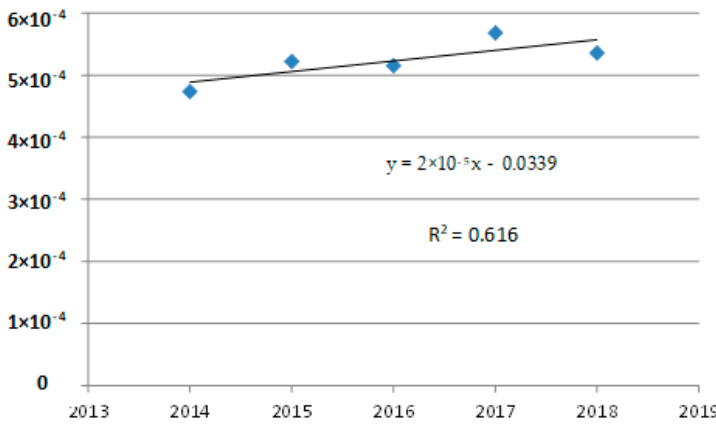
Figure 4. Trend for the period 2014–2018 in Bilbao.